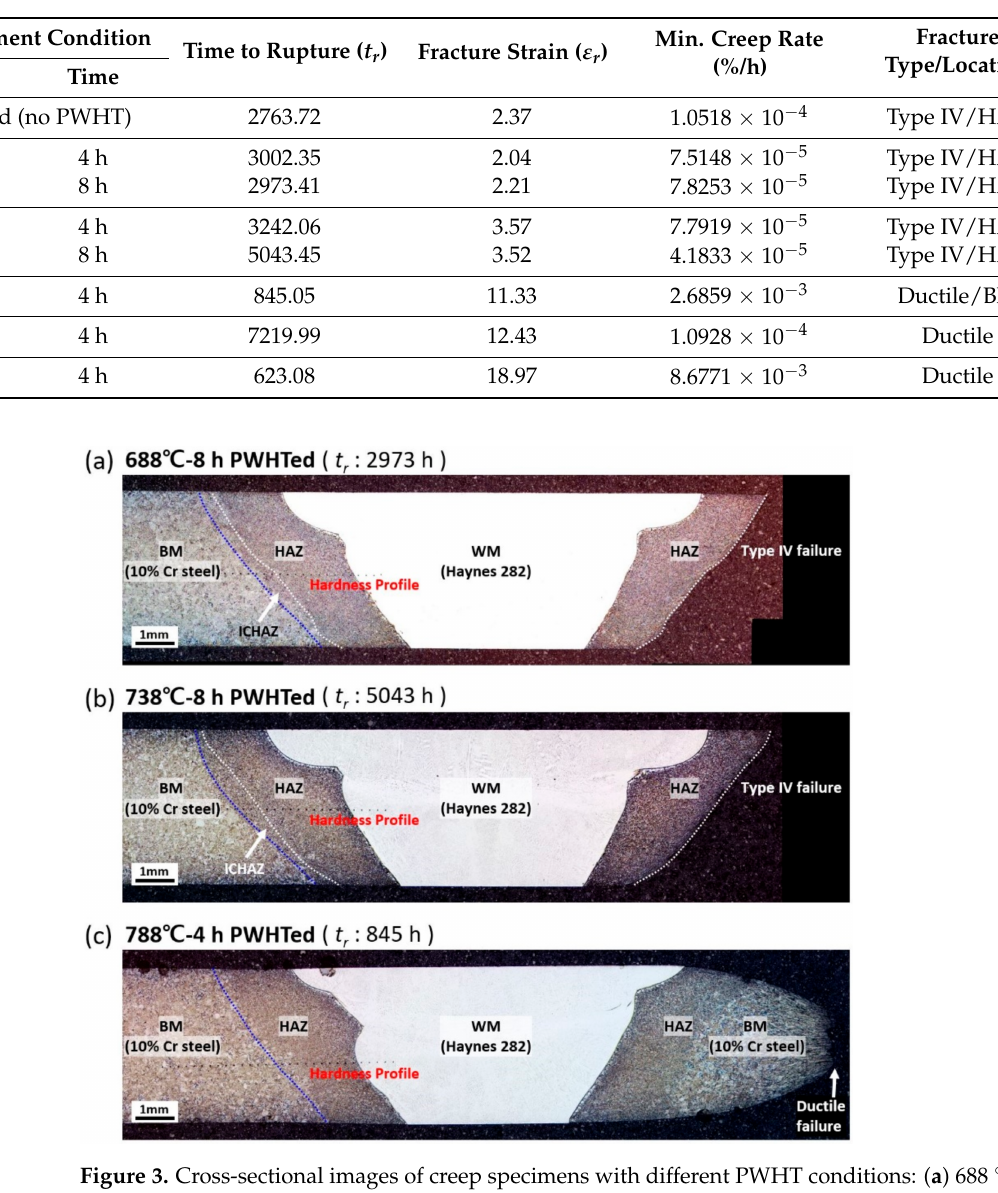
Table 2. Summary of creep test results. All tests were performed at 600 ◦ C/200 MPa.